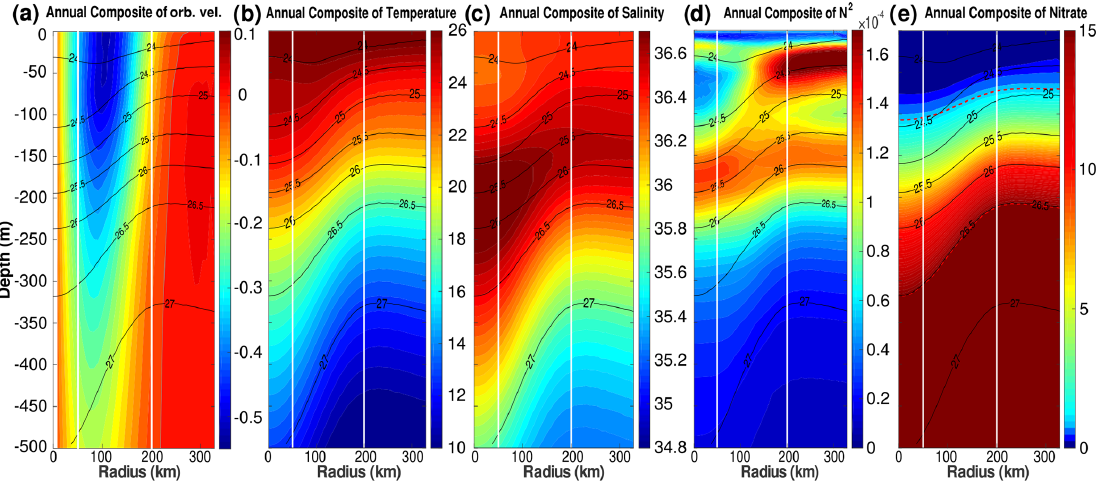
Figure 5. Annually averaged LCE composite transects of (a) orbital velocities (ms − 1 ), (b) potential temperature ( ◦ C), (c) salinity (psu), (d) squared Brunt–Väisälä frequency ( N 2 in s − 2 ) , and (e) nitrate concentration (mmolm − 3 ). Isopycnal anomalies (black contours) are superimposed on all panels. Vertical white lines delimit the three dynamical fields of the LCE composite. (e) Dashed red lines highlight two specific iso-nitrate contours: 1 and 15mmolm − 3